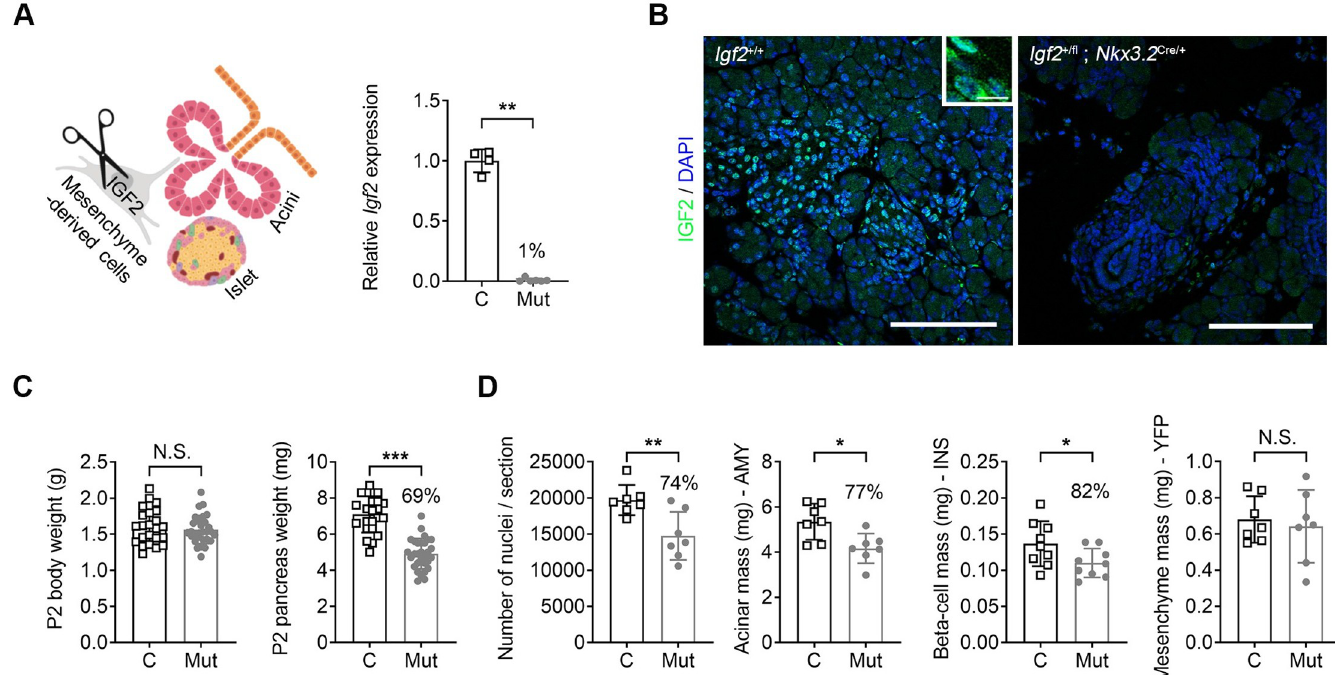
Fig 3. Impact of mesenchyme-specific deletion of Igf2 on pancreas at postnatal day 2 (P2). (A) Left: schematic representation of conditional Igf2 deletion from the pancreatic mesenchyme. Right: reduced Igf2 mRNA expression levels in FACS-isolated pancreatic mesenchyme-derived cells of mutant mice (Mut: Igf2 +/fl ; Rosa26YFP - stop +/fl ; Nkx3 . 2 Cre/+ ) compared to control littermates (C: Igf2 +/+ ; Rosa26YFP -stop +/fl ; Nkx3 . 2 Cre/+ ) measured by qRT-PCR (data normalized to Ppia and shown relative to levels in controls). (B) Representative immunofluorescence confocal microscopy showing cytoplasmatic staining (inset) for IGF2 in pancreases of control mice ( Igf2 +/+ ) and absence of signal in mutants ( Igf2 +/fl ; Nkx3 . 2 Cre/+ ). Green–IGF2; blue–DAPI staining of nuclei; scale bars– 100 μ m and 10 μ m for lower and higher magnification panels, respectively. (C) Pancreas weights are significantly reduced in mutants with conditional deletion of Igf2 in the mesenchyme (Mut: Igf2 +/fl ; Rosa26YFP -stop +/fl ; Nkx3 . 2 Cre/+ ), compared to littermate controls (C: Igf2 +/+ ; Rosa26YFP -stop +/fl ). Body weights are similar between genotypes. (D) Stereological measurements show significant reductions in the total number of nuclei/section, acinar mass and beta-cell mass (shown as %) in mutants (Mut: Igf2 +/fl ; Rosa26YFP -stop +/fl ; Nkx3 . 2 Cre/+ ), compared to littermate controls (C: Igf2 +/+ ; Rosa26YFP -stop +/fl ; Nkx3 . 2 Cre/+ ), but not for the mesenchyme mass. For all graphs, data is shown as individual values and averages ± SD; N.S.–non-significant, � p < 0.05, �� p < 0.01 and ��� p < 0.001 by unpaired Student’s t tests [panels (A), (C), and